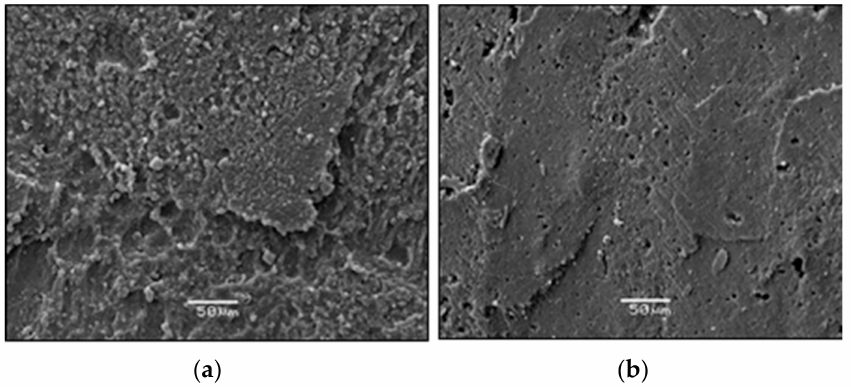
Figure 23. Rubber surface: ( a ) unmodified, ( b ) under treatment